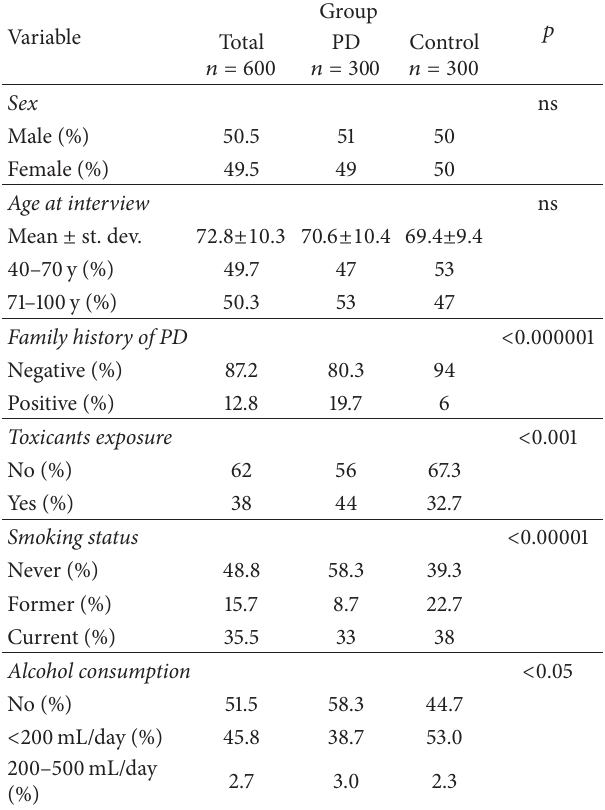
Table 1: Demographics and main risk factors in our study popula-